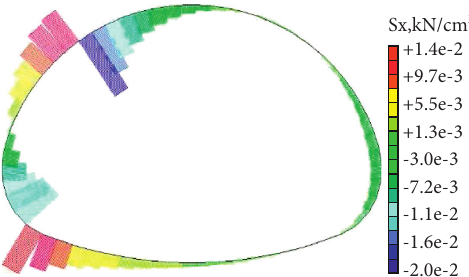
Figure 6: Horizontal expansion and excavation of pilot tunnel construction